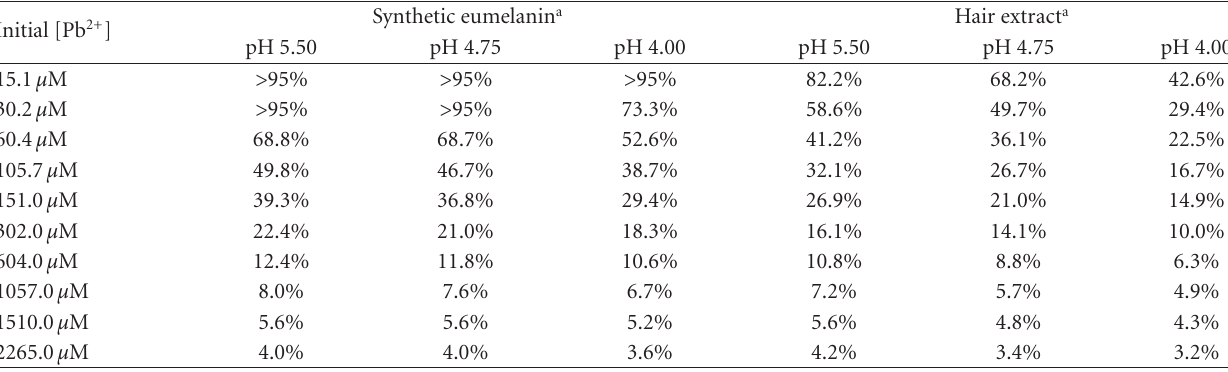
Table 2: Percentage of Pb 2+ bound at equilibrium.